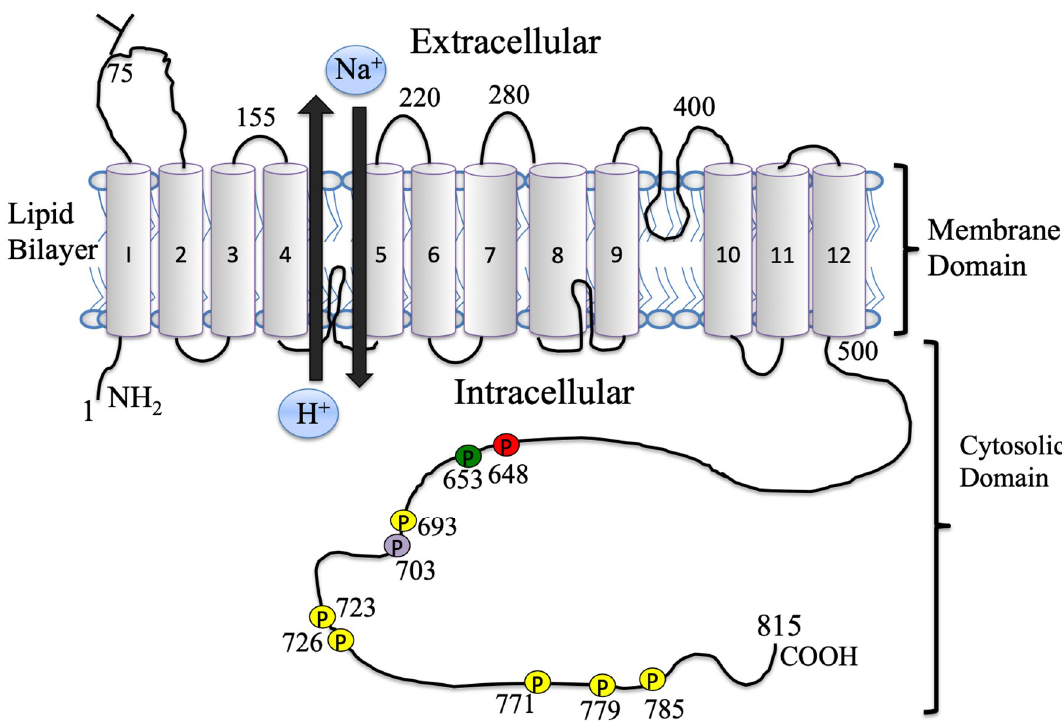
Figure 1. Illustration of the general structure of Na + / H + exchanger isoform one, within the lipid bilayer. Transmembrane segments are labeled 1–12. Some representative amino acids on extramembrane loops are indicated. Amino acid 75 denotes the N-linked glycosylation site. The approximate position of phosphorylation sites is shown on the tail—yellow for extracellular signal-regulated kinase (ERK), red for protein kinase B (AKT), green for B-Raf, and purple for p90 rsk ; see Sections 2 and 3 for details.